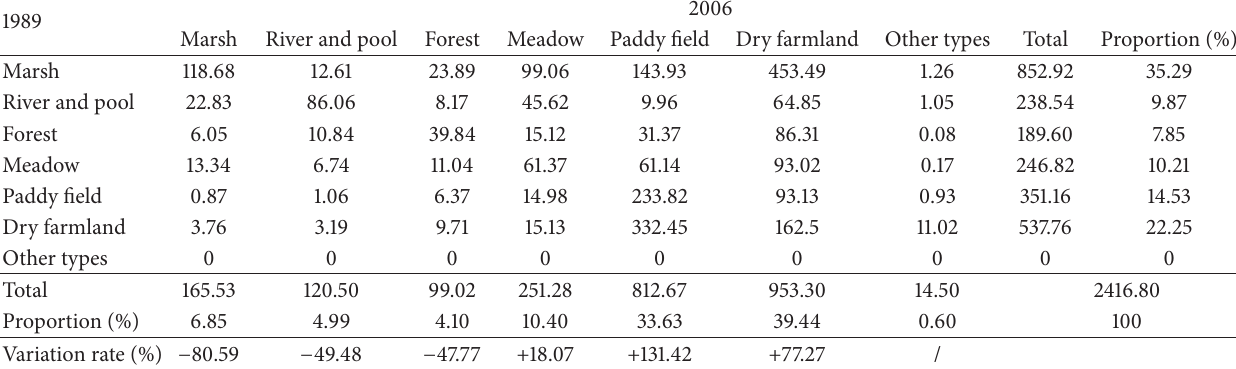
Table 2: Transformation matrix of landscape and land use within the study area during the period from 1989 to 2006 (unit: km 2